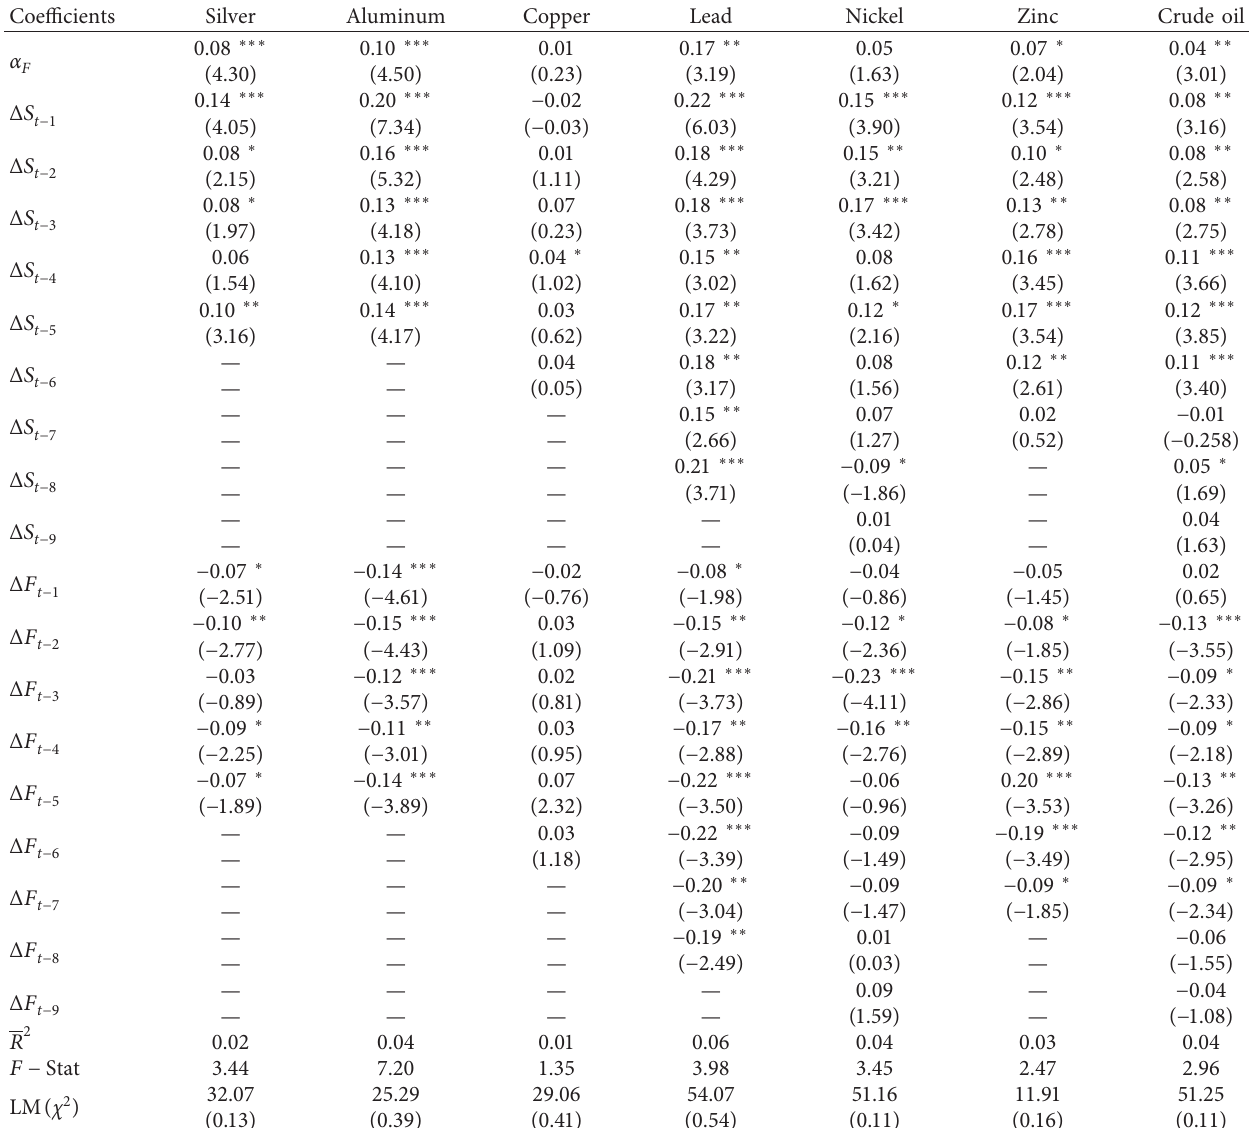
Table 10: Vector error correction model for futures price of the selected